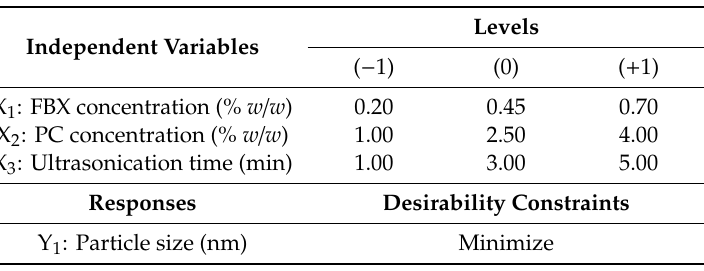
Table 1. Independent variables and responses used in the Box-Behnken design for the formulation and optimization of febuxostat into emulsomes